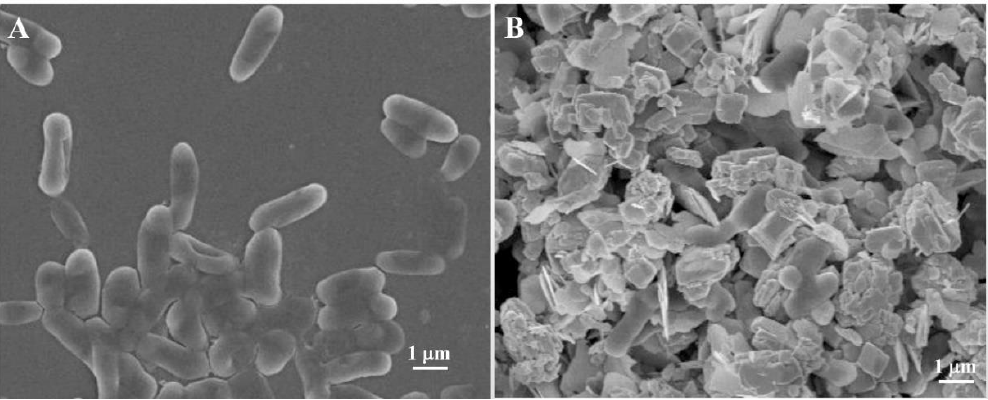
Figure 5. SEM images of E. coli ( A ) and E. coli treated with the PDA-rGO/BiVO 4 composite ( B ) .